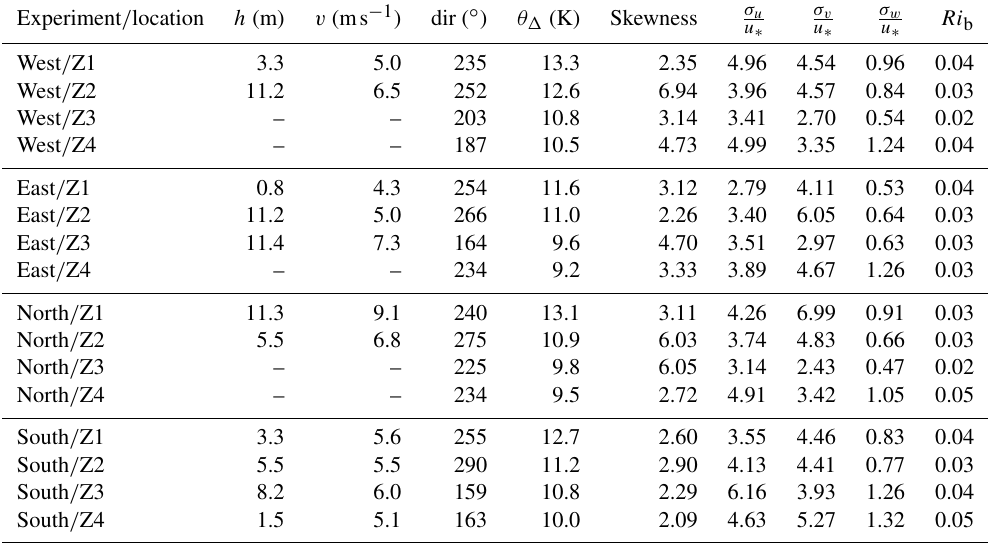
Table 1. Mean statistics at the sites (Z1–4) at 2m above the surface, derived from the large-eddy simulations. Given are the heights of the LLJ (second column), wind velocities of the LLJ (third column), wind directions (fourth column), differences between the surface temperature and the temperatures at 100m above the ground (fifth column), skewness of the vertical velocity variances (sixth column), integral turbulence scales (seventh to ninth column), and the bulk Richardson numbers (last